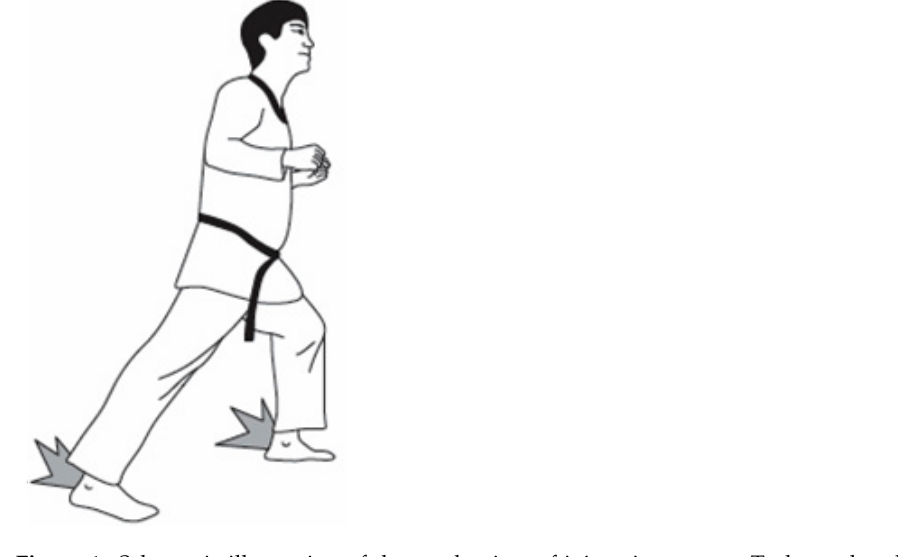
Figure 1. Schematic illustration of the mechanism of injury in a young Taekwondo athlete after kicking and landing on both feet simultaneously.